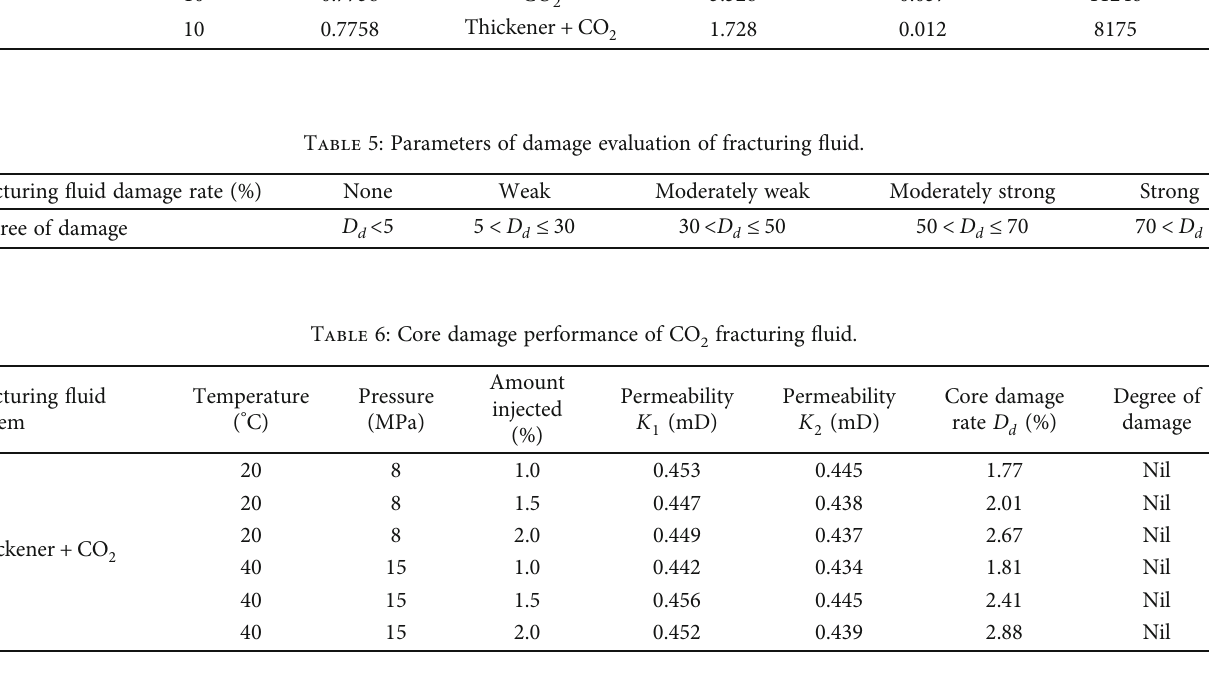
Table 4: Core leak-o ff performance of CO